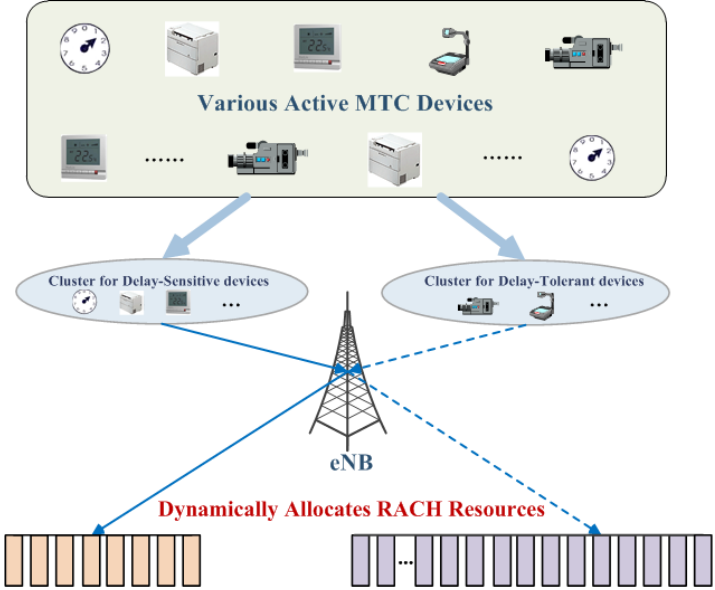
Figure 3. The diagram of the conceptual